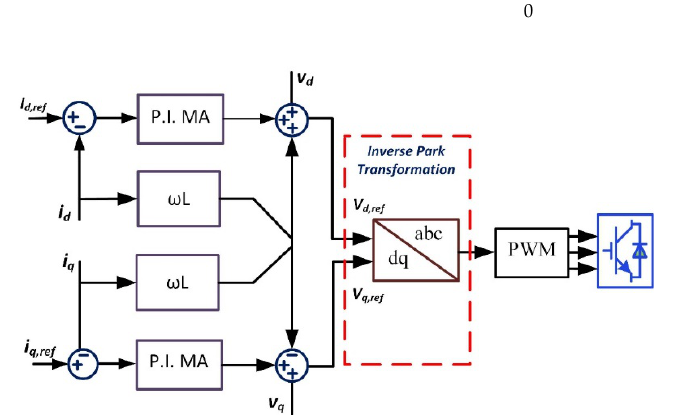
Figure 10. The control structure of ICC using MA .